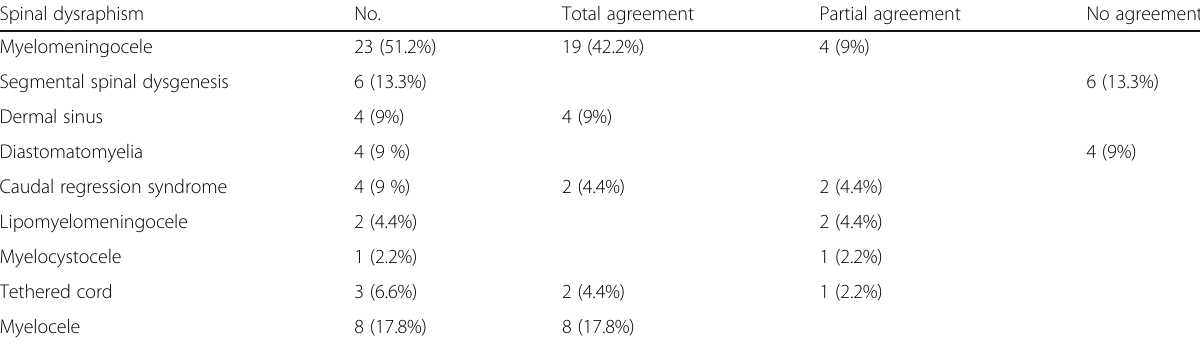
Table 4 Detailed agreement between ultrasound and MRI of different types of spinal dysraphism Spinal dysraphism